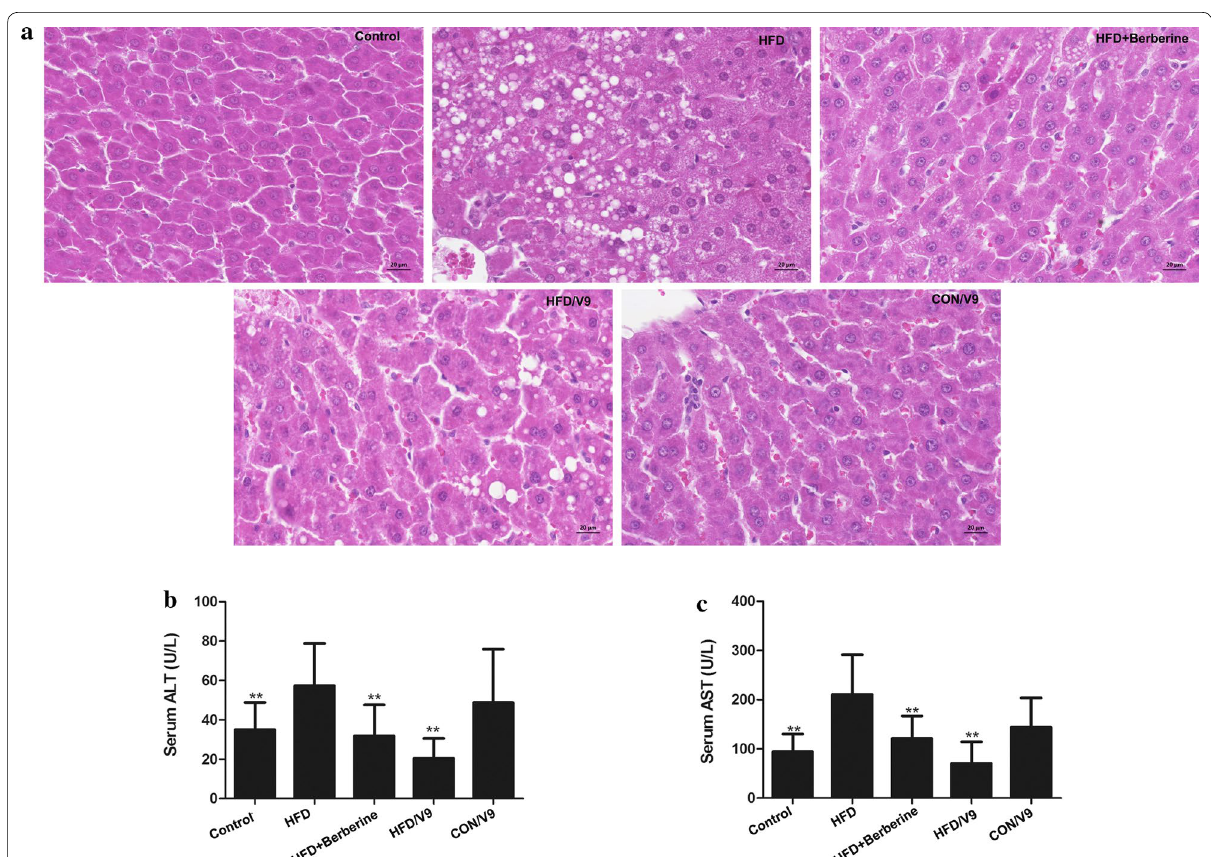
Fig. 1 Probiotic V9 improves hepatic steatosis and liver damage in HFD rats. a Paraffin-embedded liver tissues (n and stained with hematoxylin and eosin(H&E). Micrographs are representative pictures with magnification 200 measured (n 8, each group). **P < 0.01 vs HFD =